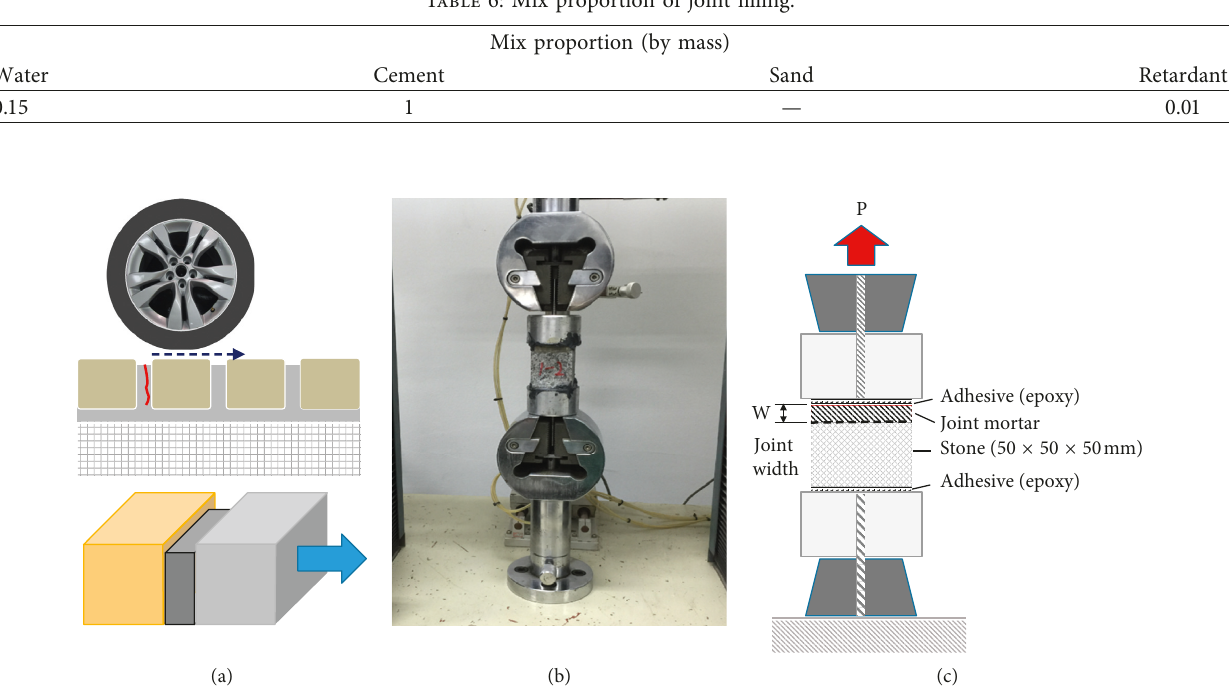
Figure 3: Adhesive strength of joint mortar. (a) Loss of adhesive strength. (b) Testing apparatus. (c) Pull-off test setup.